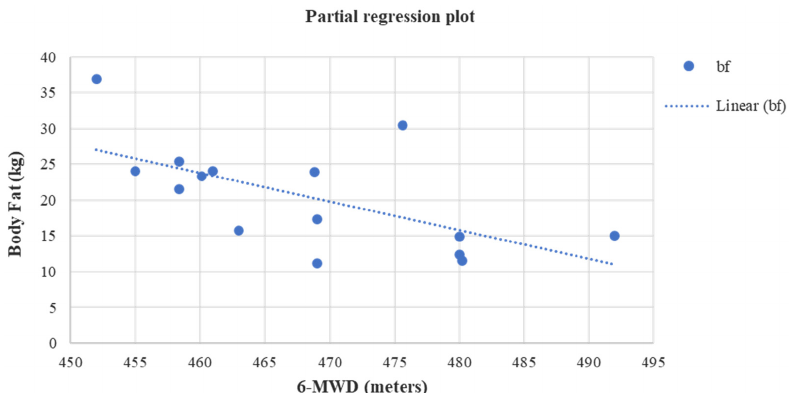
Figure 5. Linear regression analysis between the body fat (kg) and 6-MWD (meters) after four months in group A ( r = − 0.61, p = 0.01).